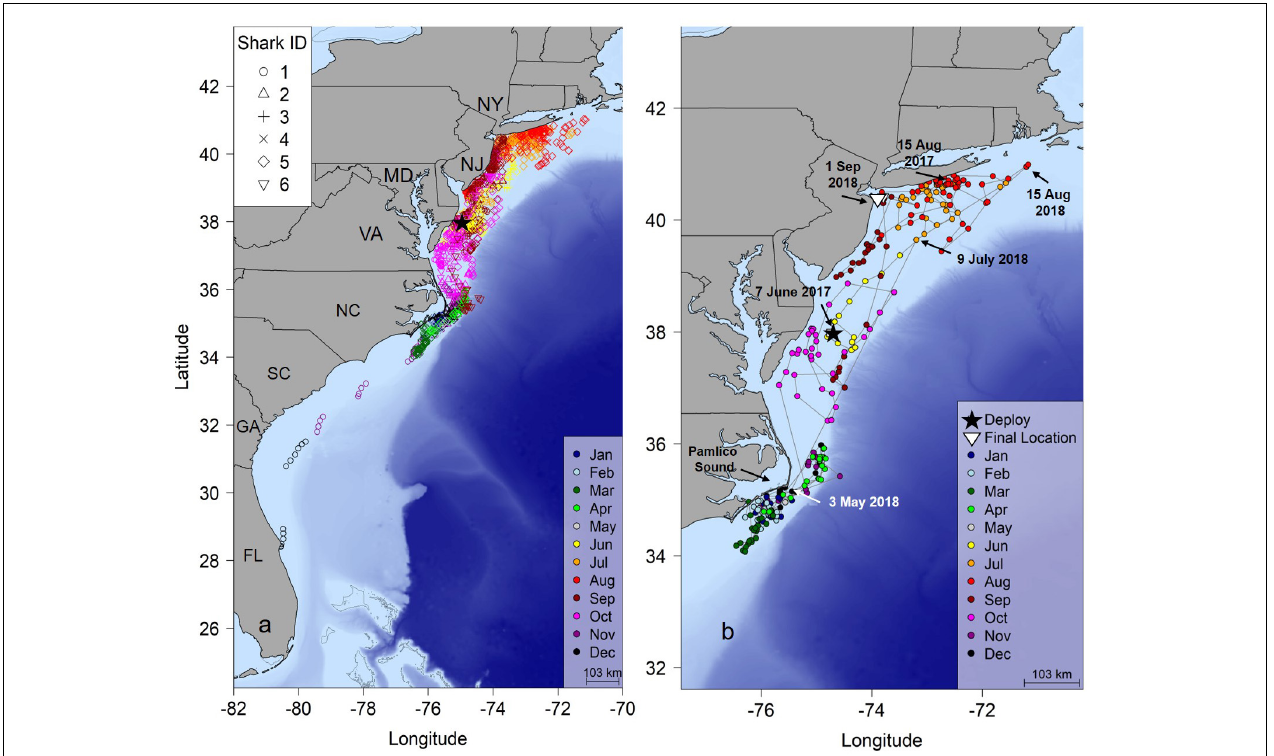
FIGURE 1 | (a) Twelve-hour position estimates for six juvenile smooth hammerhead sharks determined by a hierarchical Bayesian state space movement model (hSSM). (b) Shark #5 tracked 441 days revealing a complete migration. Black star, tagging location; NY, New York; NJ, New Jersey; MD, Maryland; VA, Virginia; NC, North Carolina; SC, South Carolina; GA, Georgia; FL,